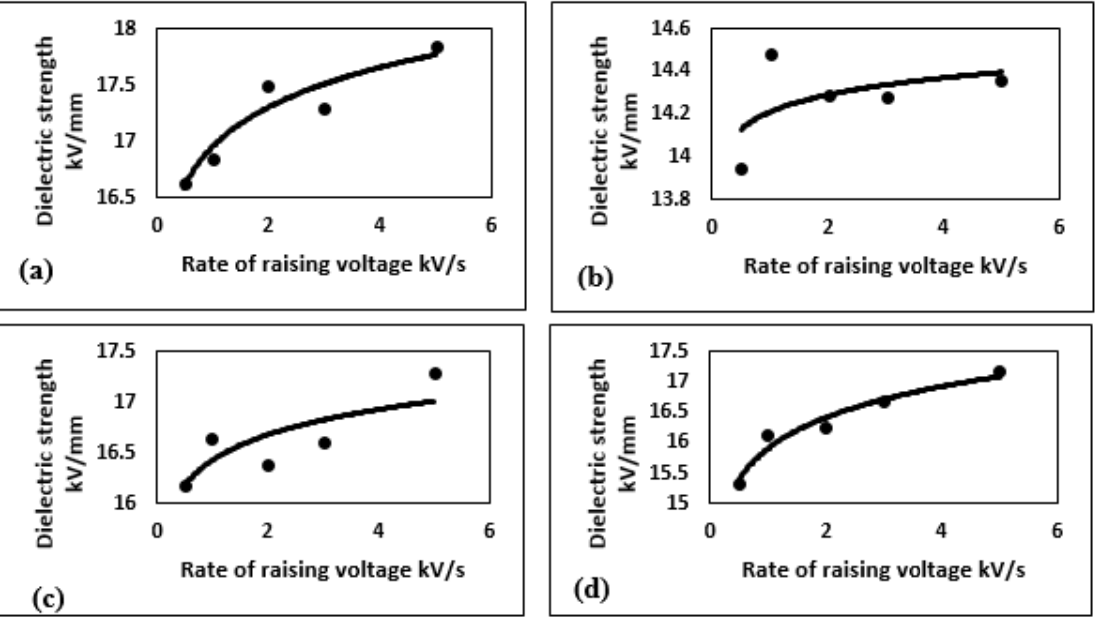
Figure 2: Variation of dielectric strength with RRV for (a) 1 wt% Al 2 O 3 (b) 2 wt% Al 2 O 3 (c) 3 wt% Al 2 O 3 and (d) 4 wt% Al 2 O 3